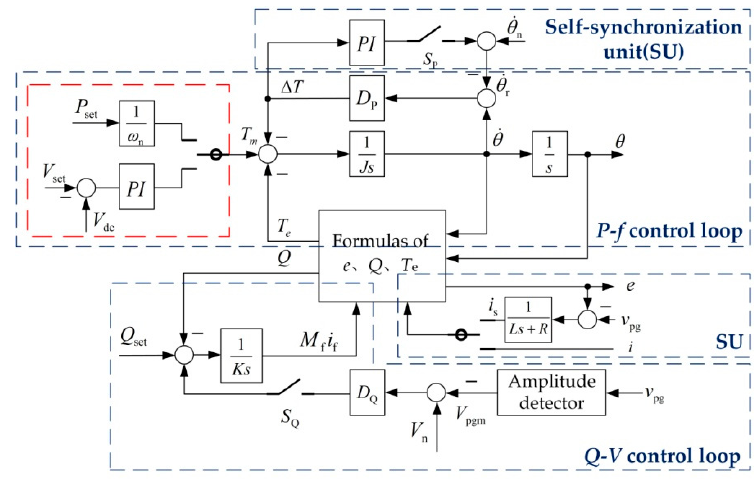
Figure 9. Inverter control strategy of the master controller.